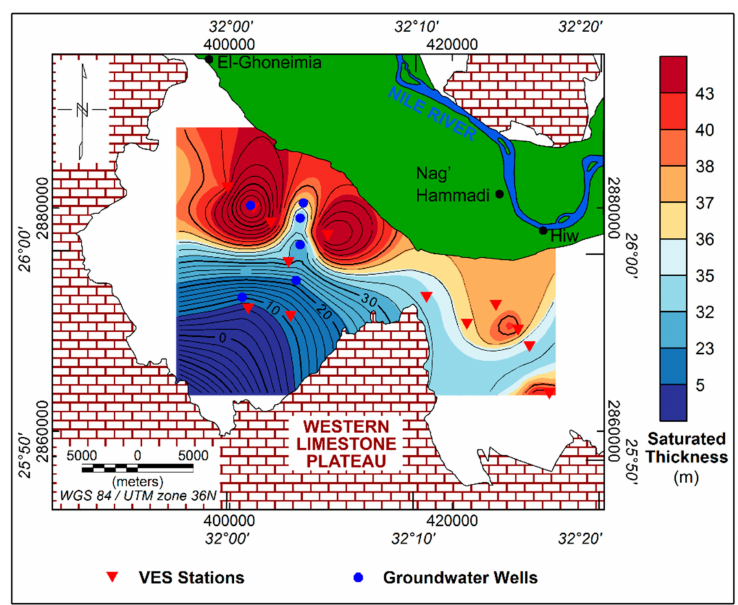
Figure 19. Saturated thickness of the Quaternary aquifer (Layer B) inferred from VES